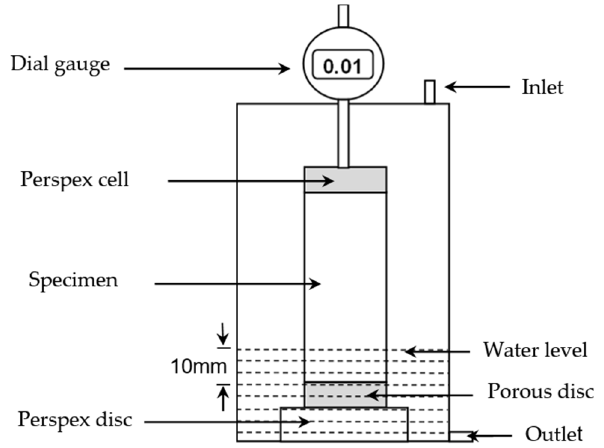
Figure 4. Schematic diagram of a perspex cell test set-up used for linear expansion measurement.